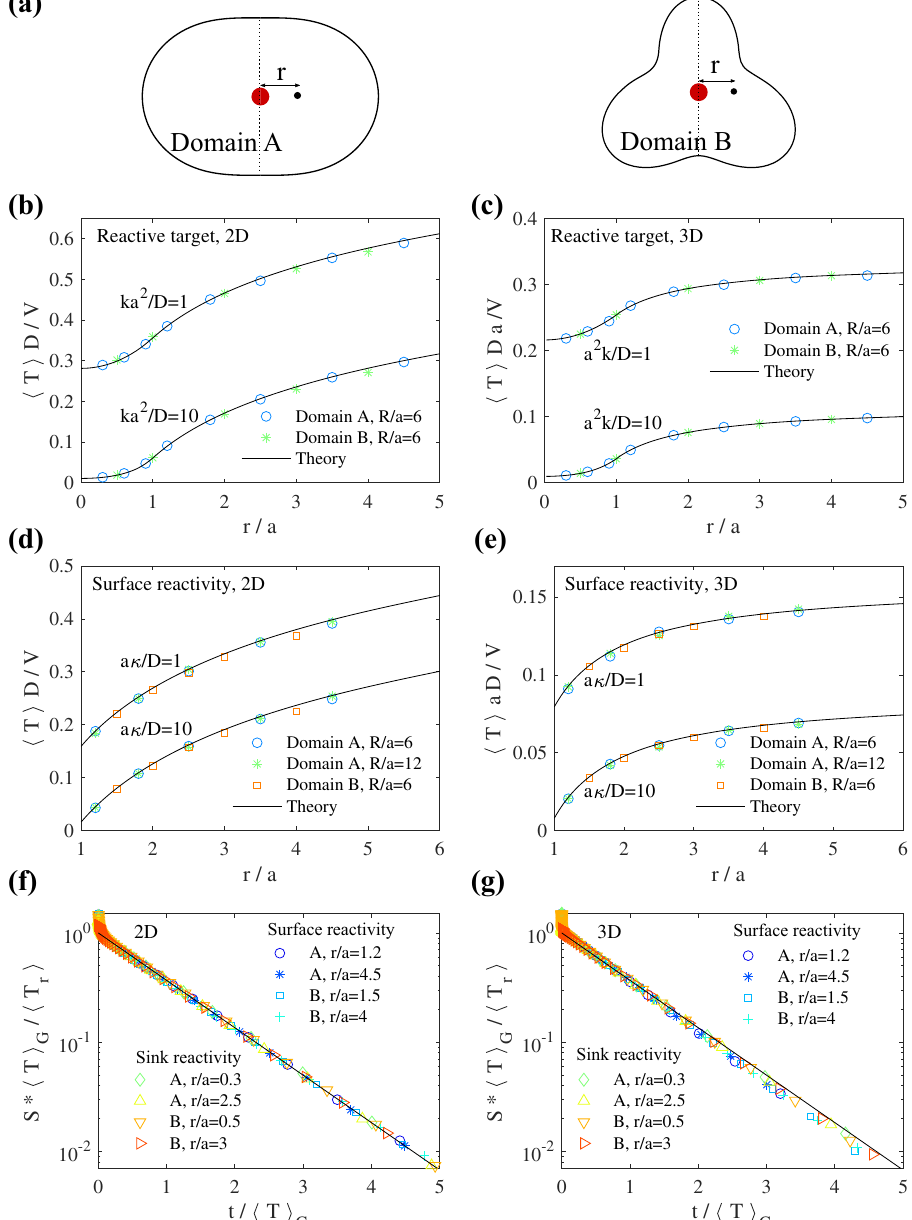
Fig. 3 Distribution of reaction times for diffusive processes in various con fi ning domains, for sink and surface reactivity. ( a ) Geometry of the con fi ning domains (called A and B ) that are considered for stochastic simulations. In 2D, these domains are de fi ned in polar coordinates by r ( θ ) = Rf ( θ ) with f ¼ 1 : 6 ð 1 þ 0 : 5cos 2 θ Þ for domain A and f ¼ 1 : 6 ð 1 þ 0 : 1sin θ þ 0 : 3sin3 θ Þ for domain B . Domains in 3D are obtained by considering revolution of 2D surfaces around the vertical dashed line. The geometry of the target (red sphere) and initial position of the random walker are indicated. In the fi gure, we have used R = 6 a . ( b ) – ( e ) Results of stochastic simulations for the mean reaction time in 2D/3D, for surface/sink reactivity, compared to our theoretical expressions. ( f ) and ( g ) Rescaled survival probabilities for 2D/3D simulations, all parameters are in legend except for R / a = 6 and ka 2 / D = 1 (for sink reactivity) and κ a / D = 1 (for surface reactivity). In 3D we evaluated 〈 T 〉 G = V ϕ ( ∞ ). In 2D, we used 〈 T 〉 G = V ϕ (1) + 〈 τ 〉 G where 〈 τ 〉 G was evaluated numerically for each domain. In all simulations we used a time step Δ t = 10 − 4 a 2 / D . For surface reactivity we implemented our simulation algorithm by using ref. 49 . Error bars (95% con fi dence intervals) are smaller than